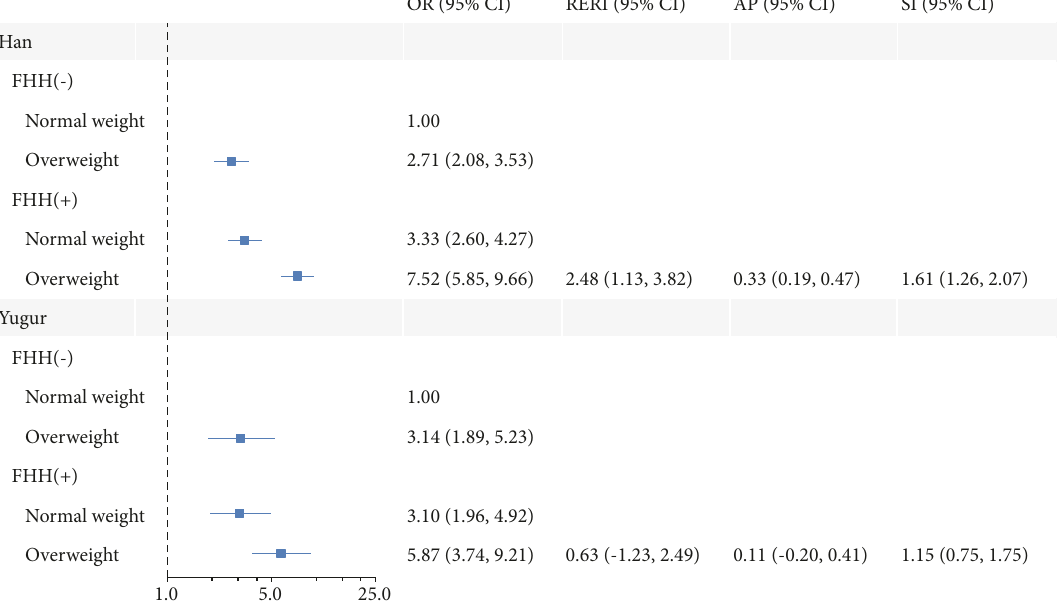
Figure 2: Associations and interactions of overweight and FHH on hypertension in Han and Yugur people in China. Models were adjusted for age and gender. FHH: family history of hypertension, RERI: the relative excess risk due to interaction,AP: the attributable proportion due to interaction, SI: the synergy index. Interaction was present if the 95% CIs of RERI and AP did not include 0 and the 95% CI of SI did not include